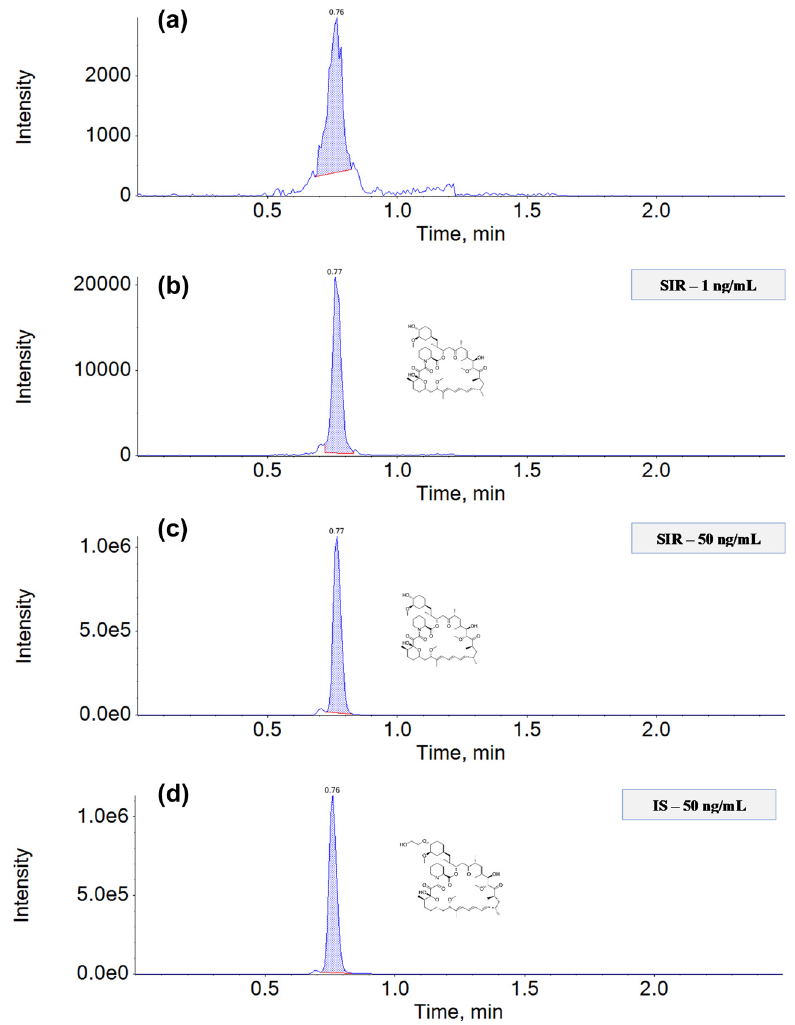
Figure 1: LC - MS/MS selected ion chromatogram with [ M + NH 4 ] + - signals of ( a ) blank whole blood; ( b ) whole blood sample spiked with SIR at a concentration of 1 ng/mL; ( c ) whole blood sample spiked with SIR at a level of 50 ng/mL; and ( d ) whole blood spiked with IS at a level of 50